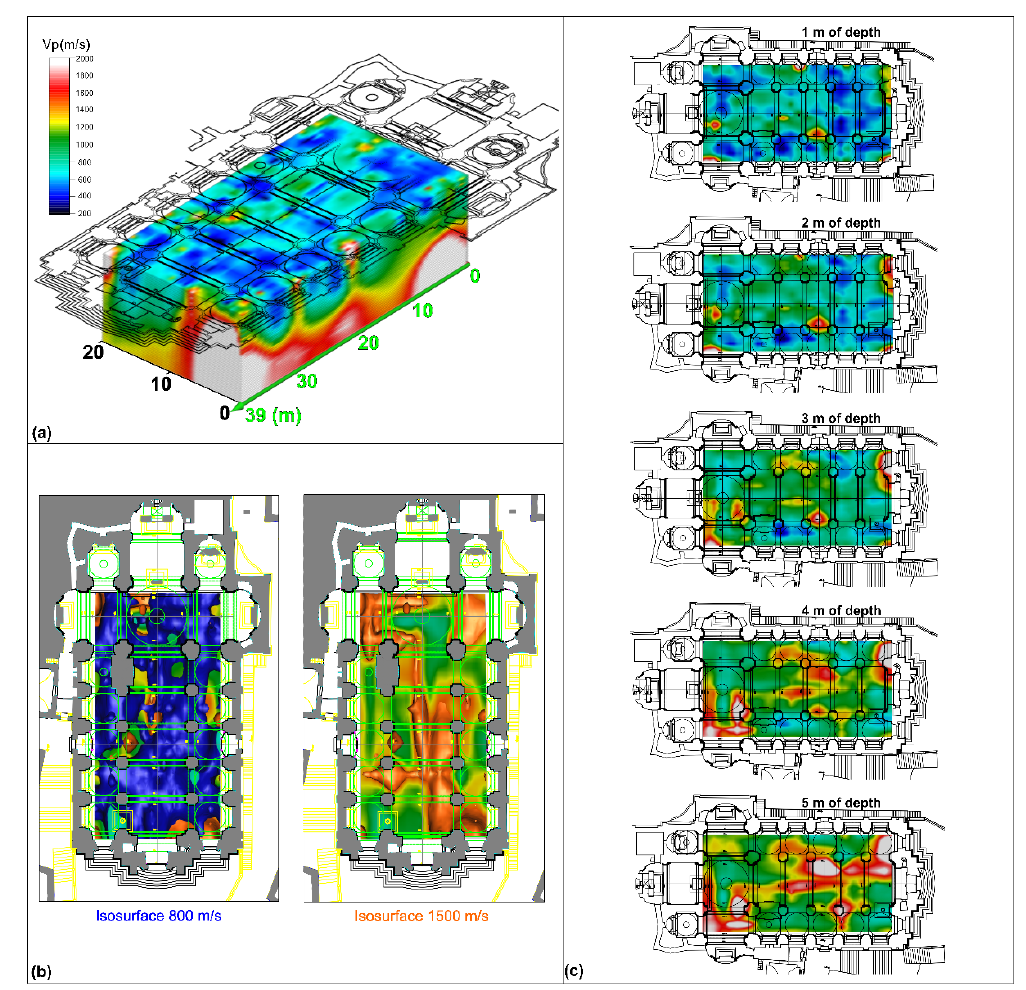
Figure 9. ( a ) 3D subsoil model obtained from the interpolation between seismic tomography sec- tions; ( b ) isosurfaces for longitudinal wave velocity values (V p ) of 800 and 1500 m/s; ( c ) depth slices. The ambient noise samplings were processed by dividing the traces into windows of 20 s each, using a triangular function and 10% smoothing in the frequency range 0.5–256 Hz (i.e., half sampling frequency). The reliability of the curve obtained and the clarity of the peaks are determined based on the criteria expressed in the SESAME guidelines [39].